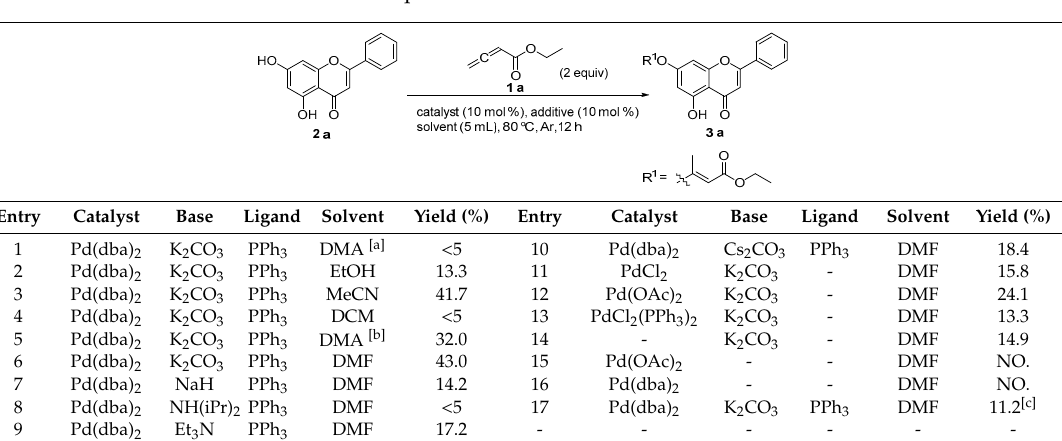
Table 1. Optimization of reaction conditions.